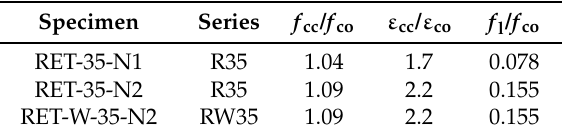
Predictions of the American Concrete Institute (ACI) 440.2R [48] model for the tested